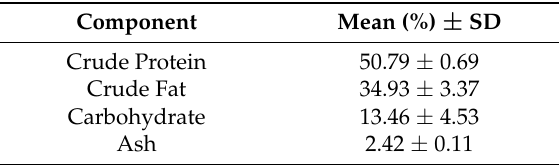
Table 1. Proximate composition of L. migratoria (% based on dry